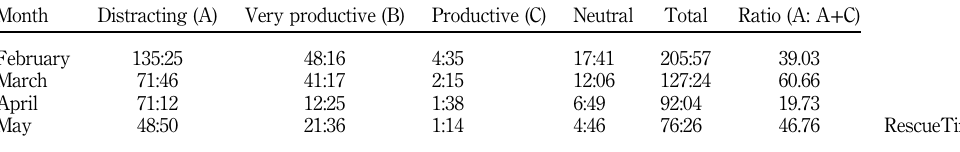
Table I. RescueTime statistics